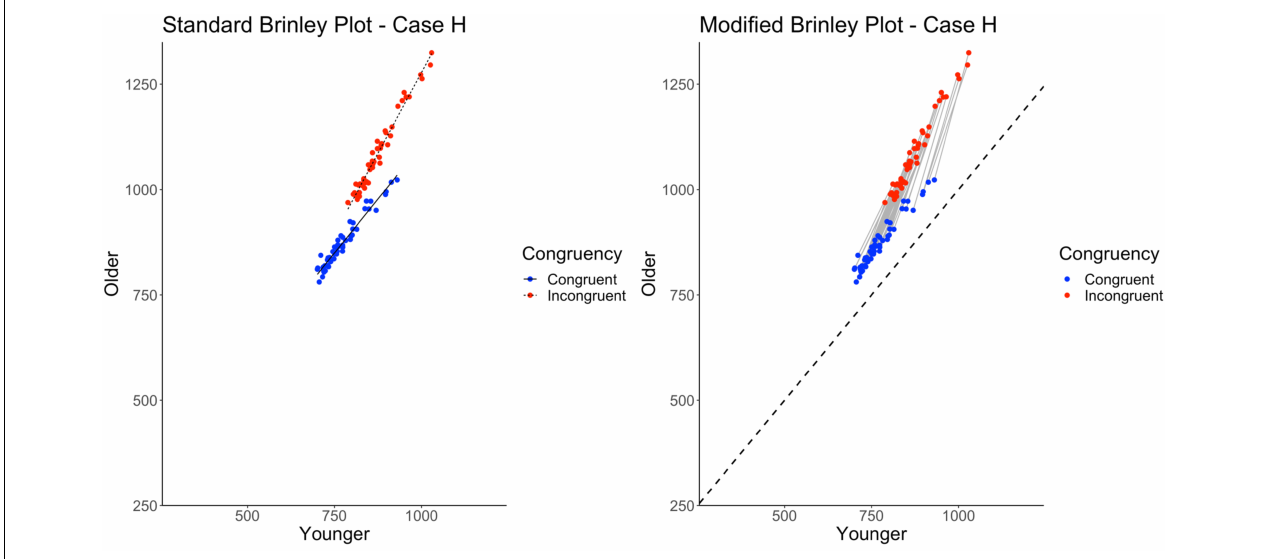
FIGURE 10 | Standard and modified Brinley plots—Case H data. Standard and modified Brinley plots (left and right, respectively) for the Case H simulated data which was simulated such that stronger interactions were systematically introduced for some studies but not others. Means (SD) used for Case G were as follows: Young Congruent = 700 (150), Young Incongruent = 800 (150), Old Congruent = 750 (200), Old Incongruent = 900